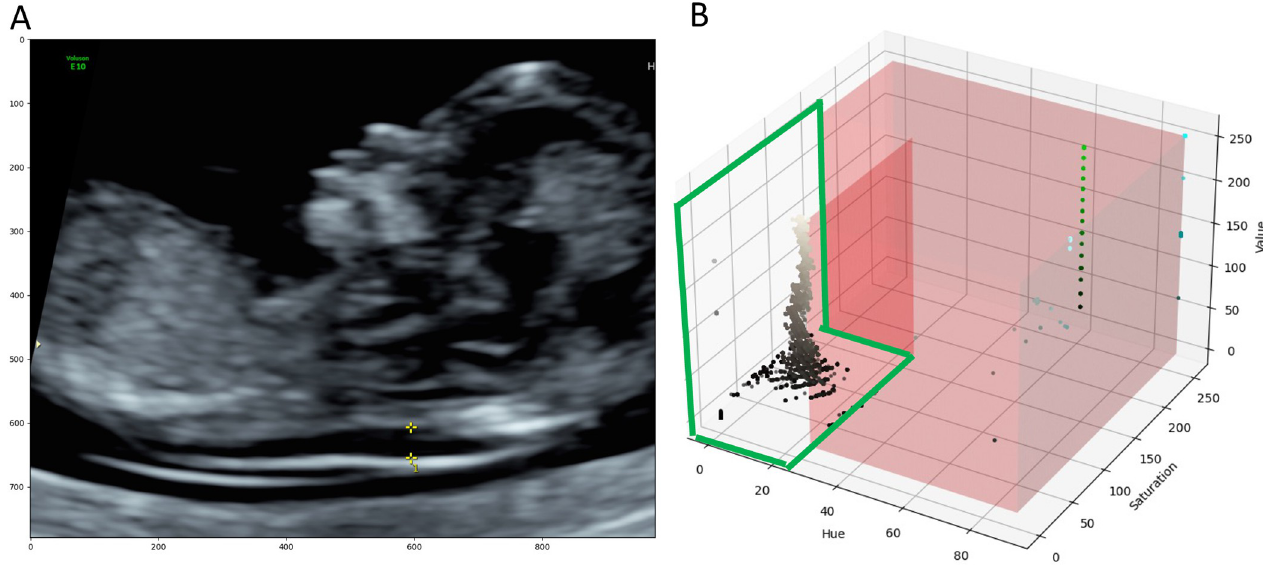
Fig 2. Identifying image annotations on a normal NT scan. (A) Image annotations included calipers, text, icons, and profile traces, all of which were removed prior to model training. (B) 3D Scatter Plot of HSV image data. Each point represents one image pixel and its associated HSV values. The red region highlights the range of values which do not belong to the grayscale ultrasound image. The area encircled in green shows pixel values that belong to the grayscale ultrasound image. Grayscale images had H, S and V values ranging from 0–27, 0–150 and 0–255, respectively.